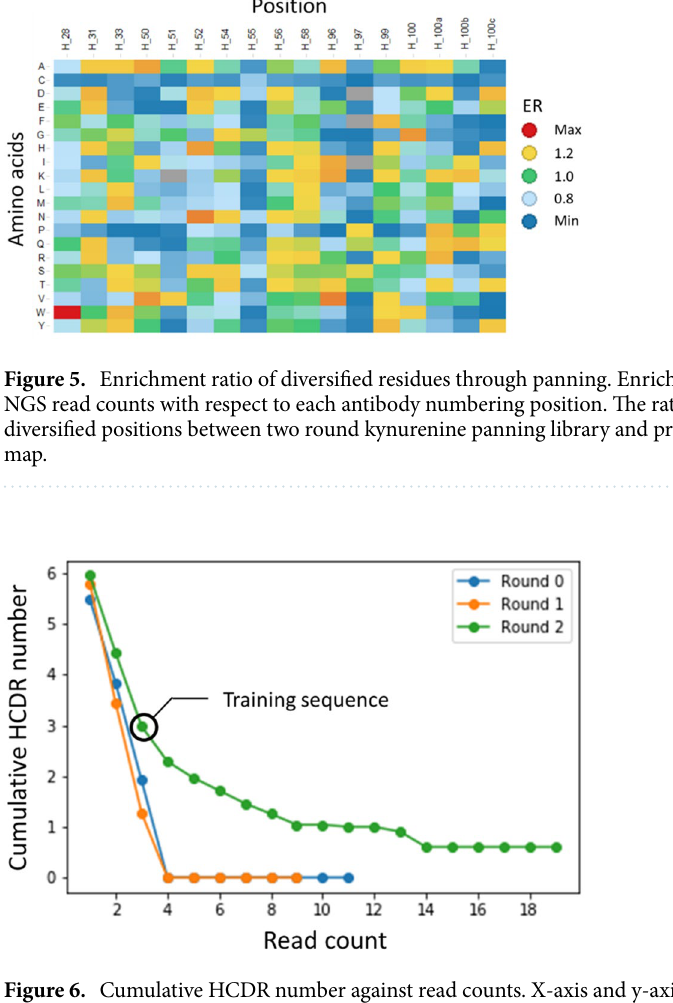
Figure 6. Cumulative HCDR number against read counts. X-axis and y-axis represent read counts and cumulative HCDR number, respectively. (blue: before panning, orange: one round, green: two round) are shown. Black circle indicates training sequences used in the deep generative model.